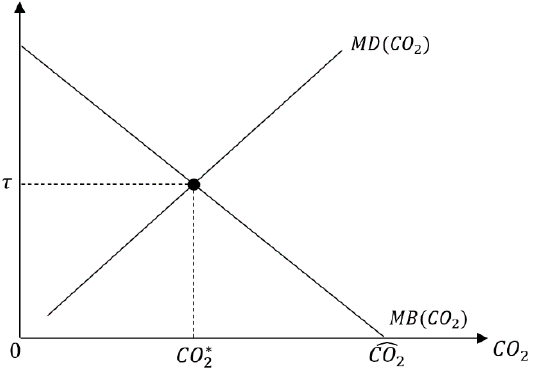
Figure 2. Net benefit maximization of level of CO 2 emissions.